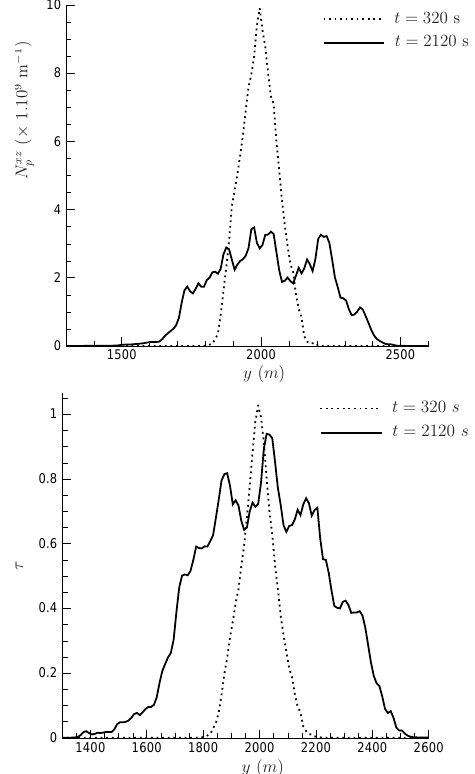
lations V D 1 (vortex/early dissipation regimes) and D 1 (dissipation